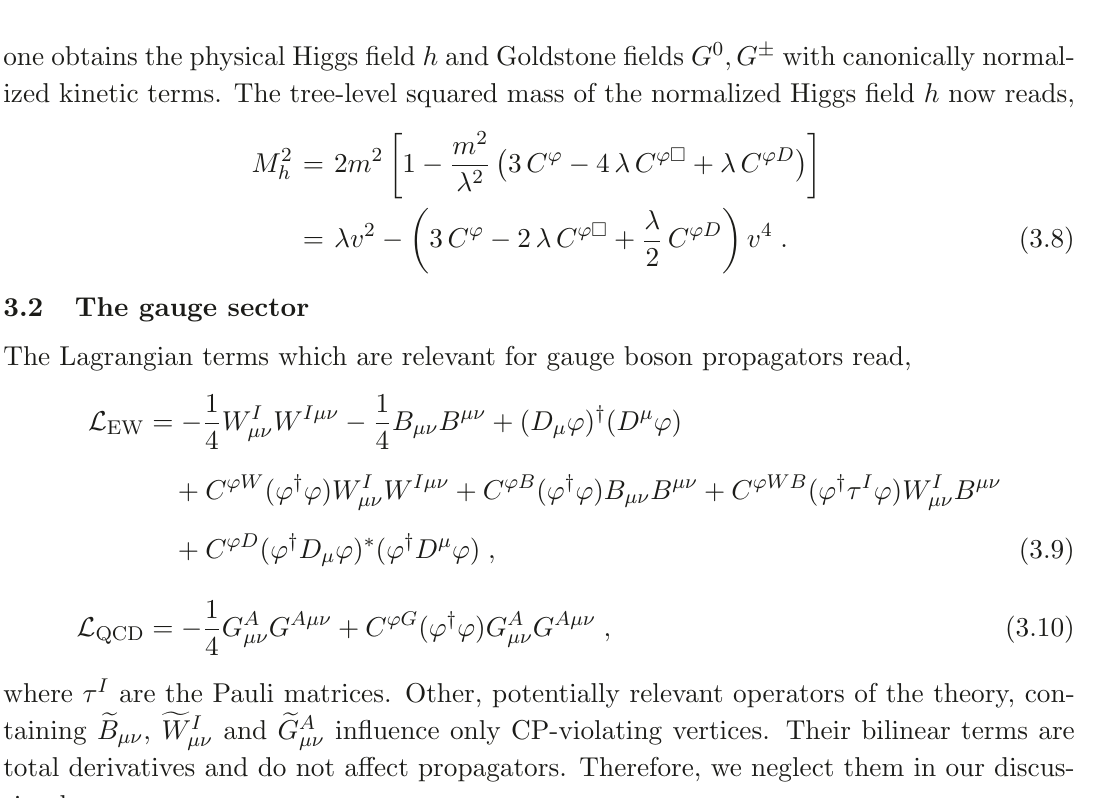
Table 3 . Four-fermion operators (from ref. [11]). For brevity we suppress fermion chiral indices L, R